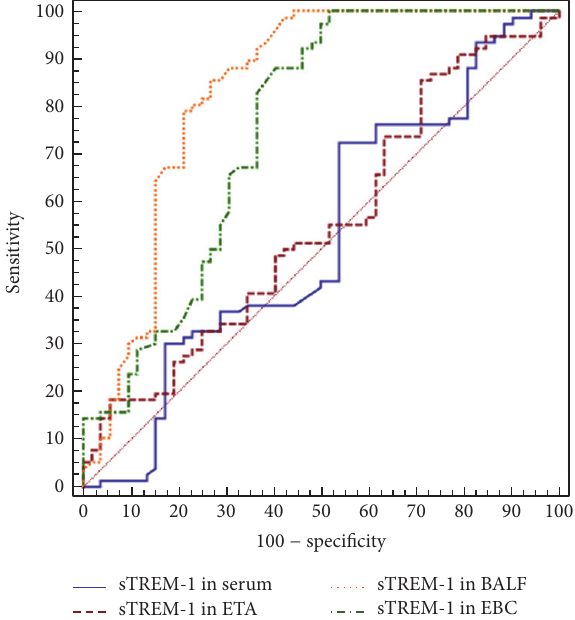
Figure 2: Receiver-operating characteristic curves (ROC) of soluble triggering receptor expressed on myeloid cells-1 (sTREM-1) in serum, endotracheal aspiration (ETA), bronchoalveolar lavage fluid (BALF), and exhaled breath condensate (EBC)